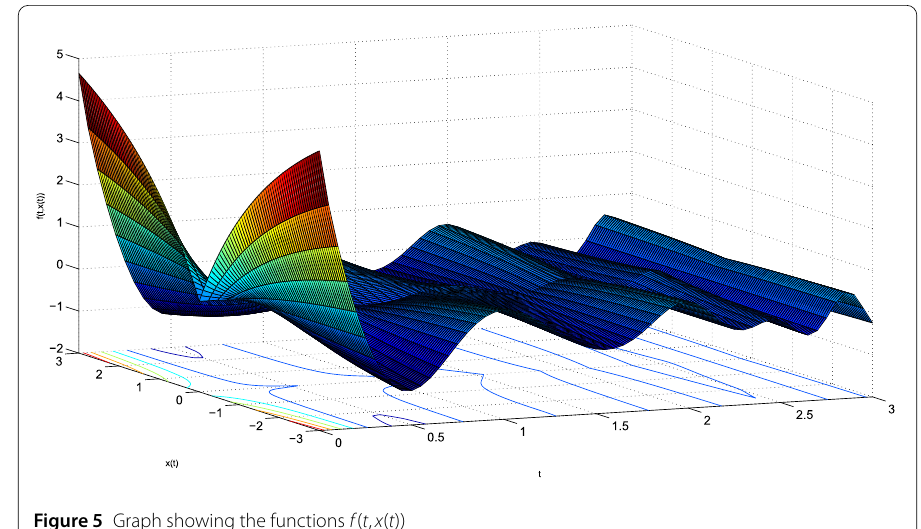
Figure 5 Graph showing the functions f ( t , x ( t